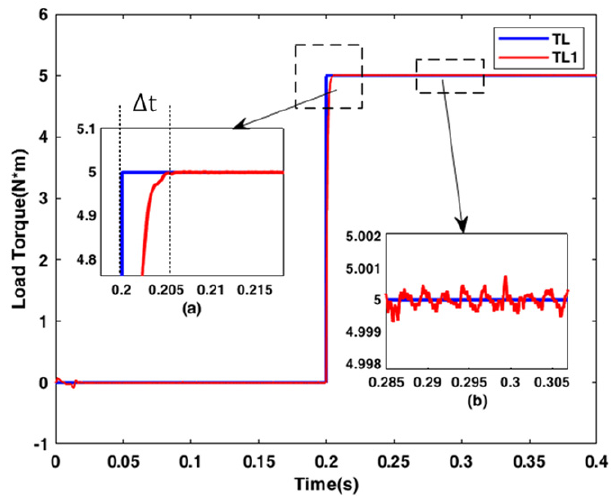
Figure 6. Observation results of load torque: ( a ) convergence time, ( b ) torque fluctuation. In Figure 7, the speed change in the new SMC with or without the observation disturbance is compared. “New-SMC” represents the speed change curve under the control of the new sliding mode controller designed, whereas “SSFDO-CSMC” represents the speed curve under the compound sliding mode controller with the symmetrical S-type function disturbance observer. Figure 7a shows the starting performance curve of the motor and Figure 7b shows the disturbance rejection ability of the motor.